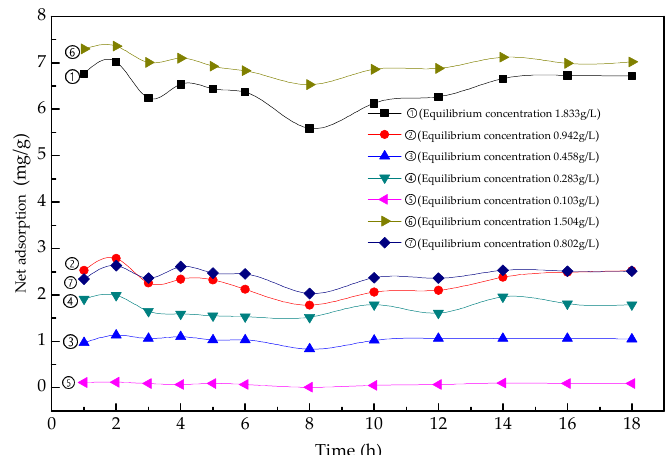
Figure 10. Relationship between the net asphalt adsorption capacity of the steel slag and time under different equilibrium concentrations.